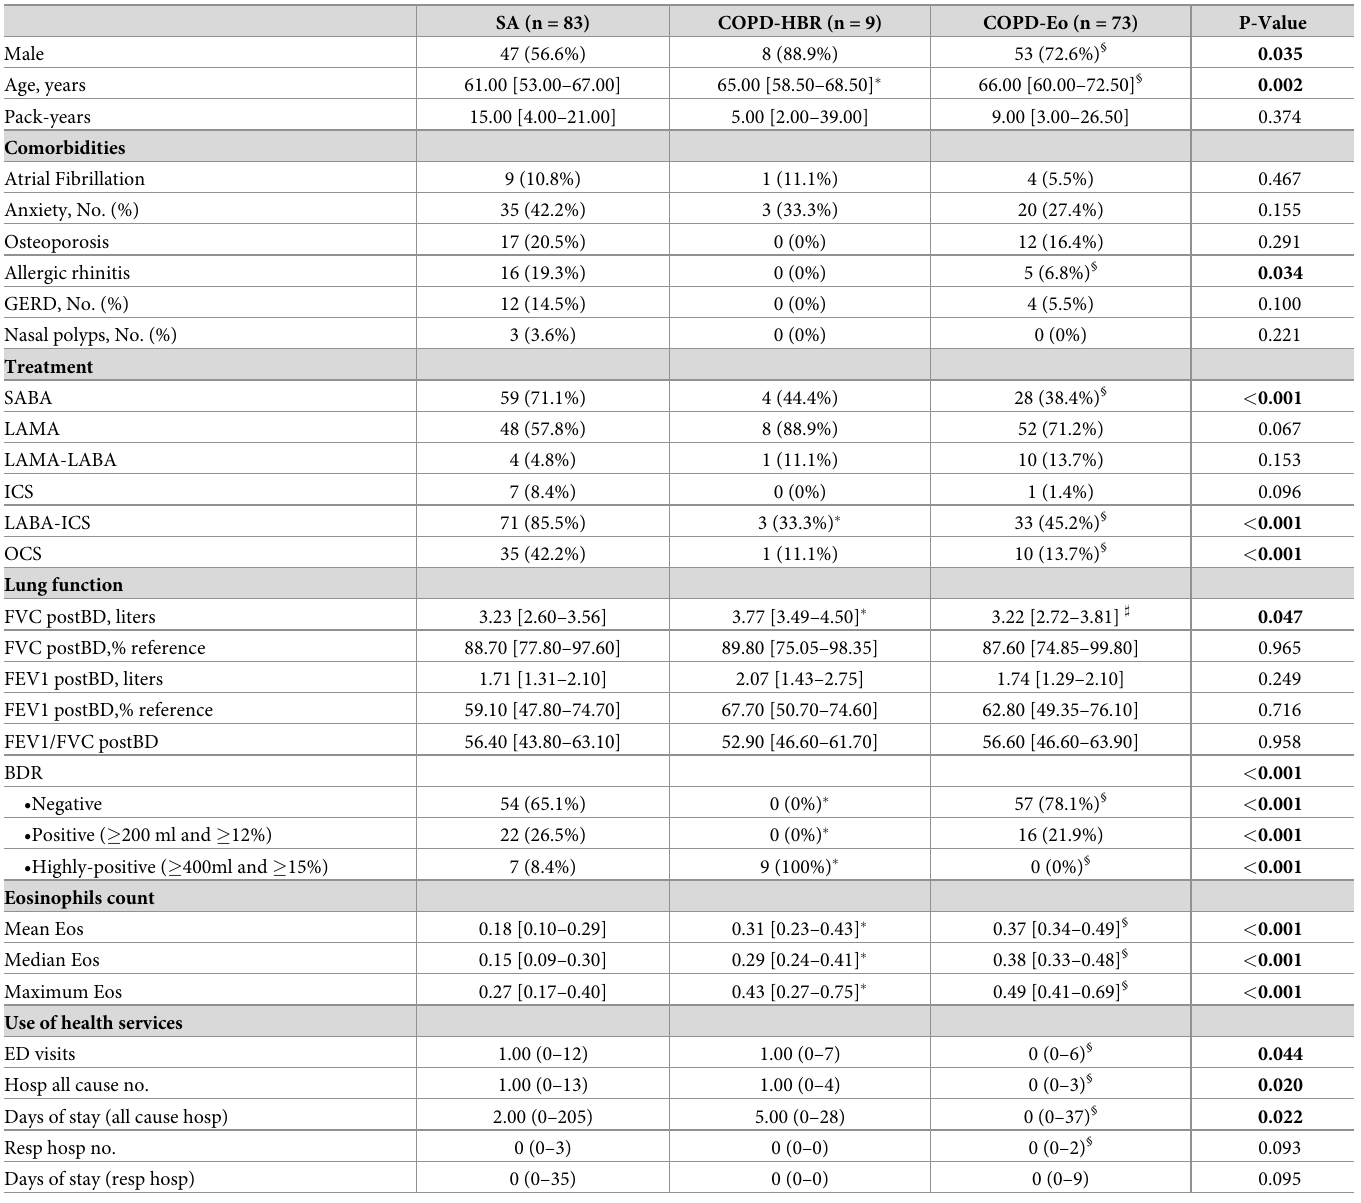
Table 2. Demographic and clinical characteristics of the three ACO